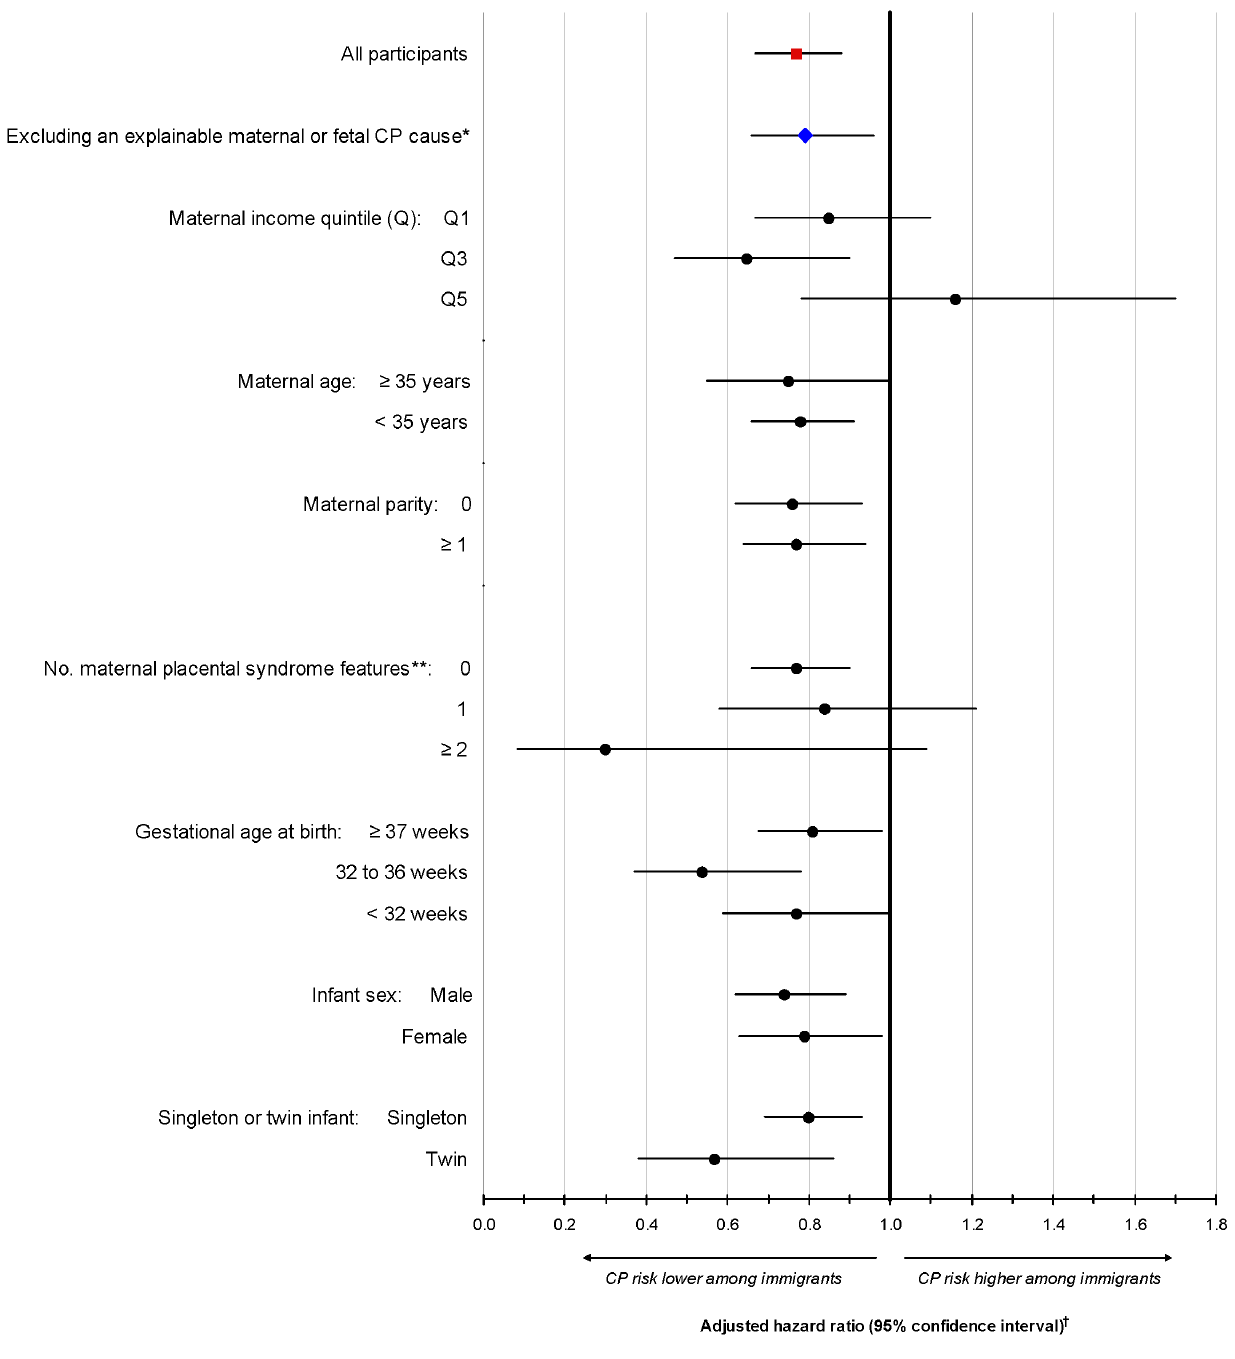
Figure 2. Risk of cerebral palsy (CP) among all participants (red square), those without a potential explainable cause of CP (blue diamond), and all participants stratified by maternal or newborn characteristics (black circles). All data were analyzed using the main Cox proportional hazard model.